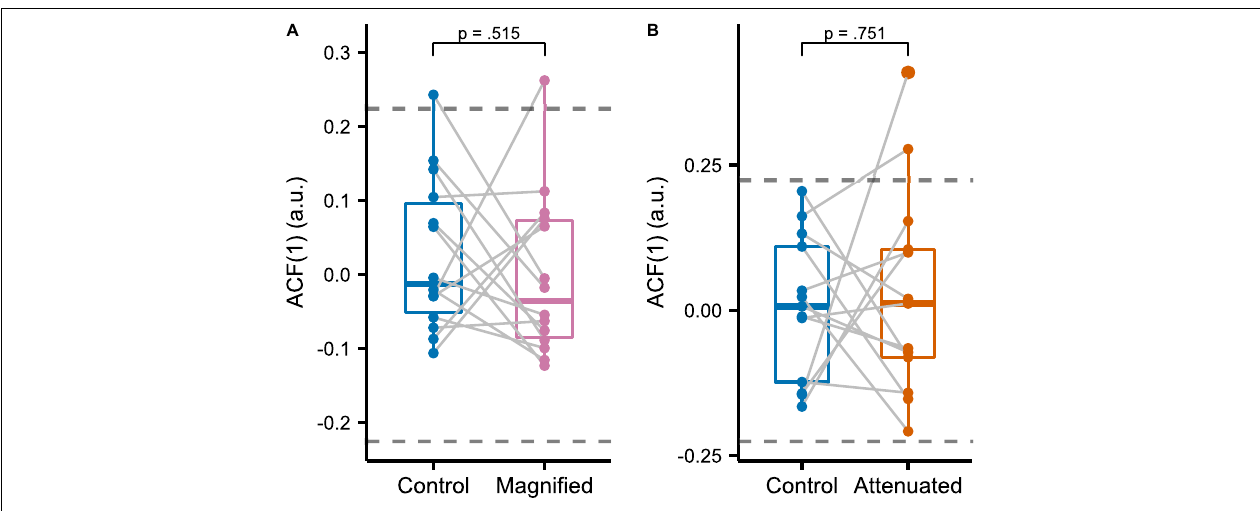
FIGURE 7 | Sample lag 1 autocorrelation functions [ACF(1)] for formant data measured in the initial portion of the vowel and averaged across F1 and F2 for Control versus Magnified (A) and Control versus Attenuated (B) conditions of the Variability task. Dashed lines indicate the large sample 95% confidence interval of ACF(1) for a white noise process with sample size 75 (the number of trials per condition). Each dot represents an individual